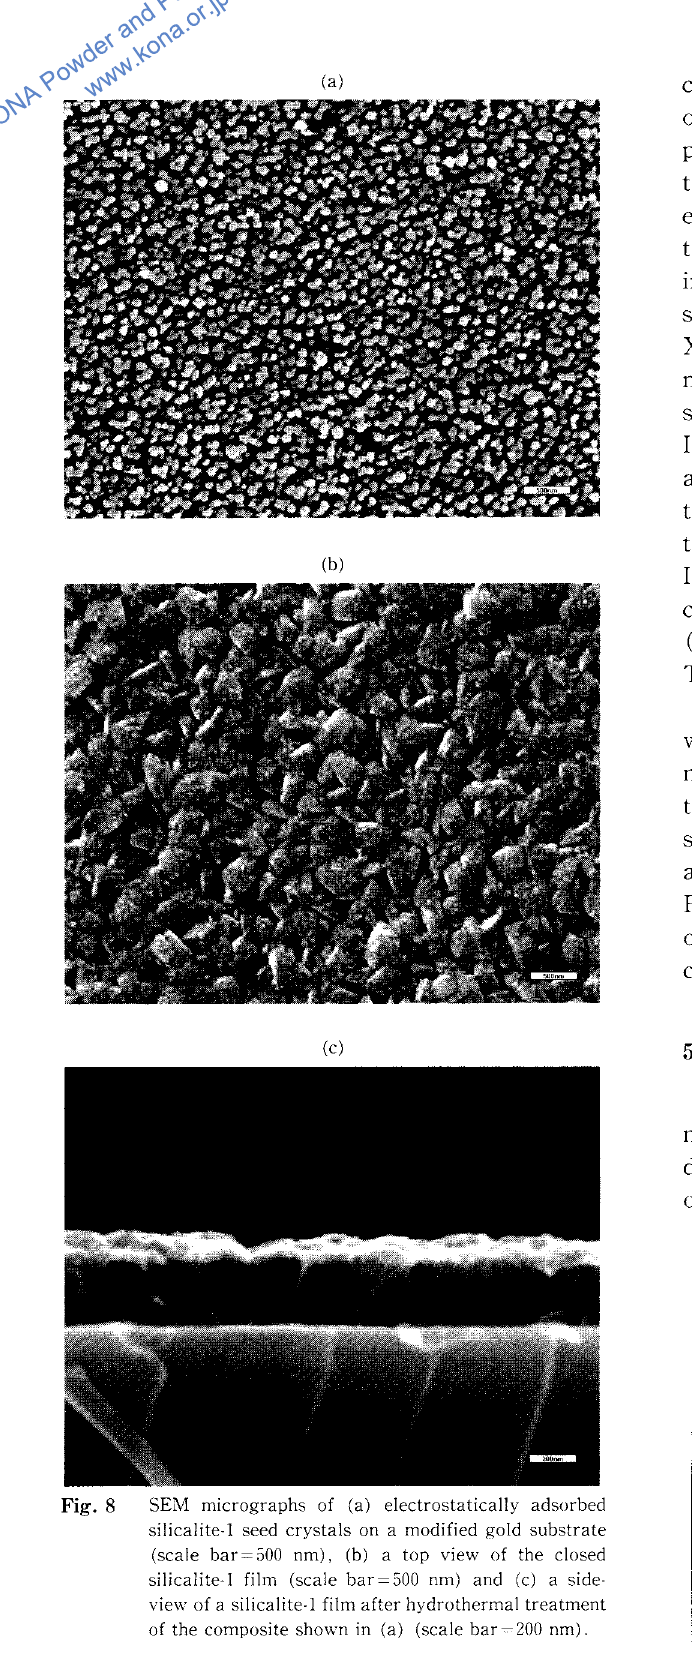
Fig. 8 SEM micrographs of (a) electrostatically adsorbed silicalite-1 seed crystals on a modified gold substrate (scale bar=SOO nm), (b) a top view of the closed silicalite-1 film (scale bar=500 nm) and (c) a side view of a silicalite-1 film after hydrothermal treatment of the composite shown in (a) (scale bar- 200